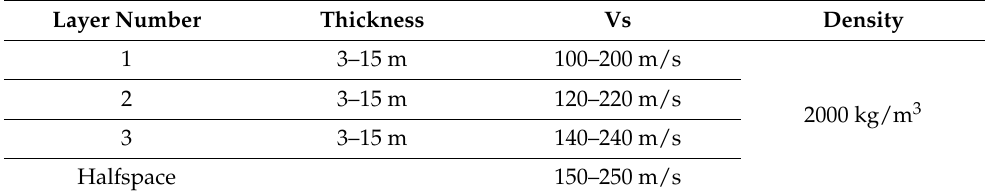
Figure 2. ( a ) f-k spectrum. ( b ) Dispersion curve. ( c ) The 1000 best fitting S-wave velocity profiles. The color of the lines represents the misfit, as indicated in the color bar. Table 2. Properties of the initial model used for the inversion of the surface waves.